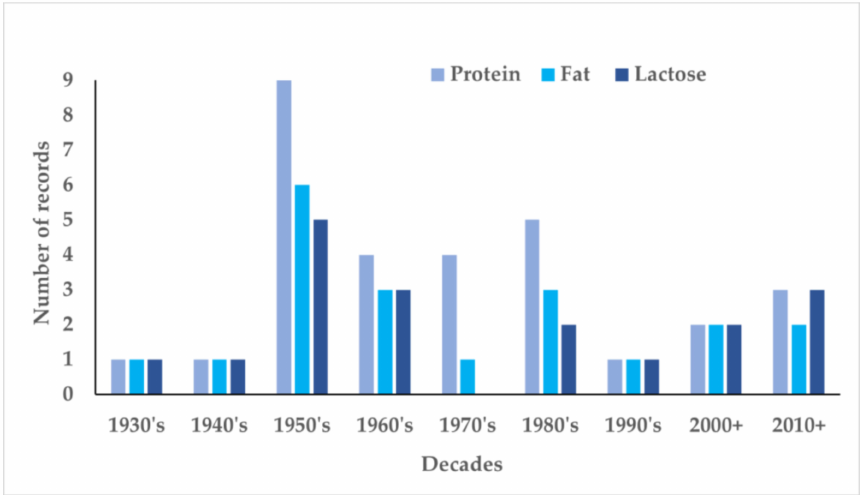
Figure 2. Decade wise records on protein, fat and lactose in Indian mothers’ milk